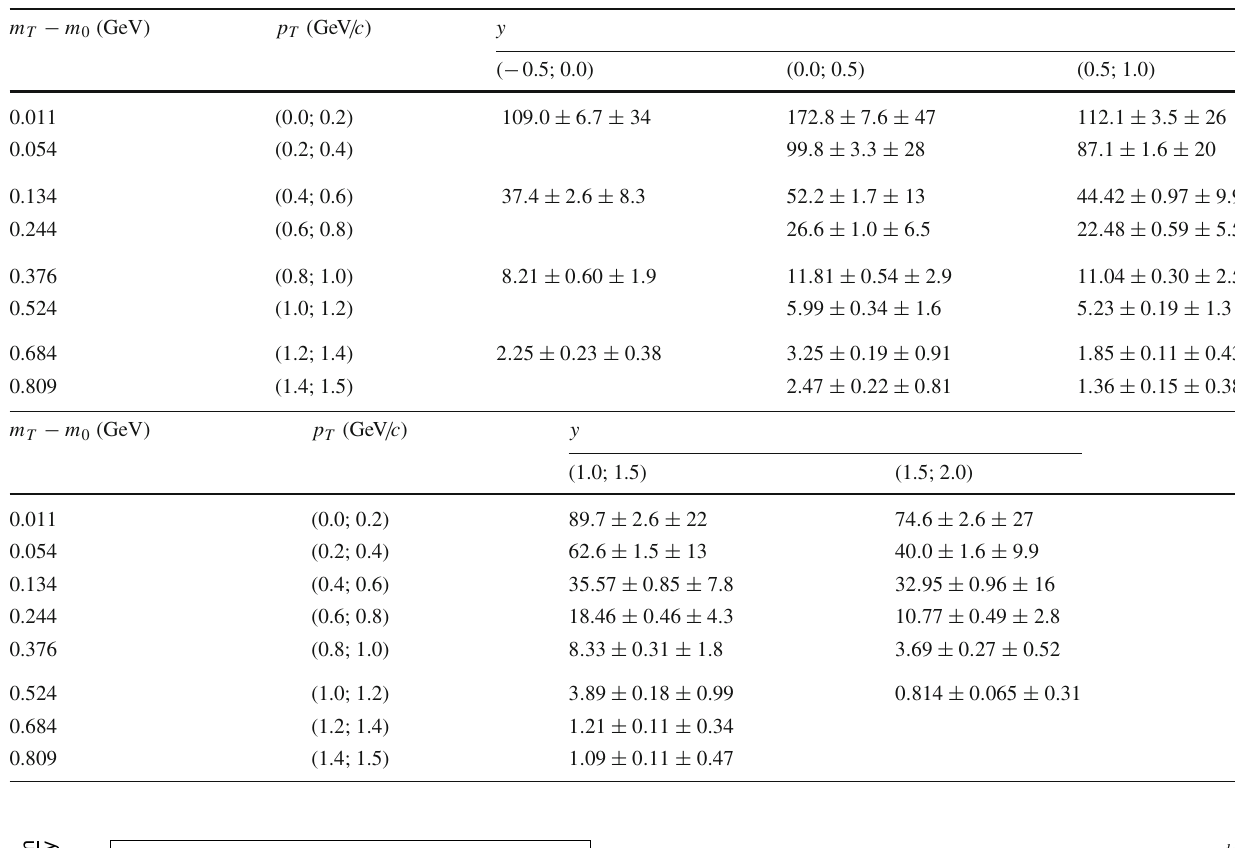
d 2 n given in units of 10 − 3 (GeV) − 2 and presented in Fig. 11; the values of m T − m 0 m T dm T dy